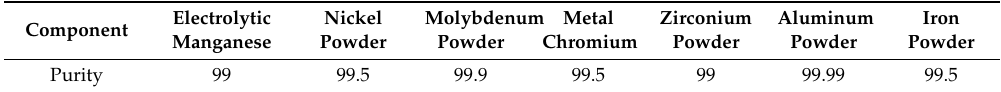
Table 5. Mass fraction of test powder (mass, wt %).